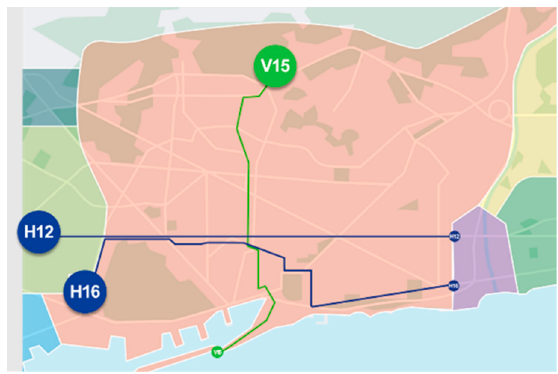
Figure 3. Overview of the ASSURED demo lines in Barcelona.